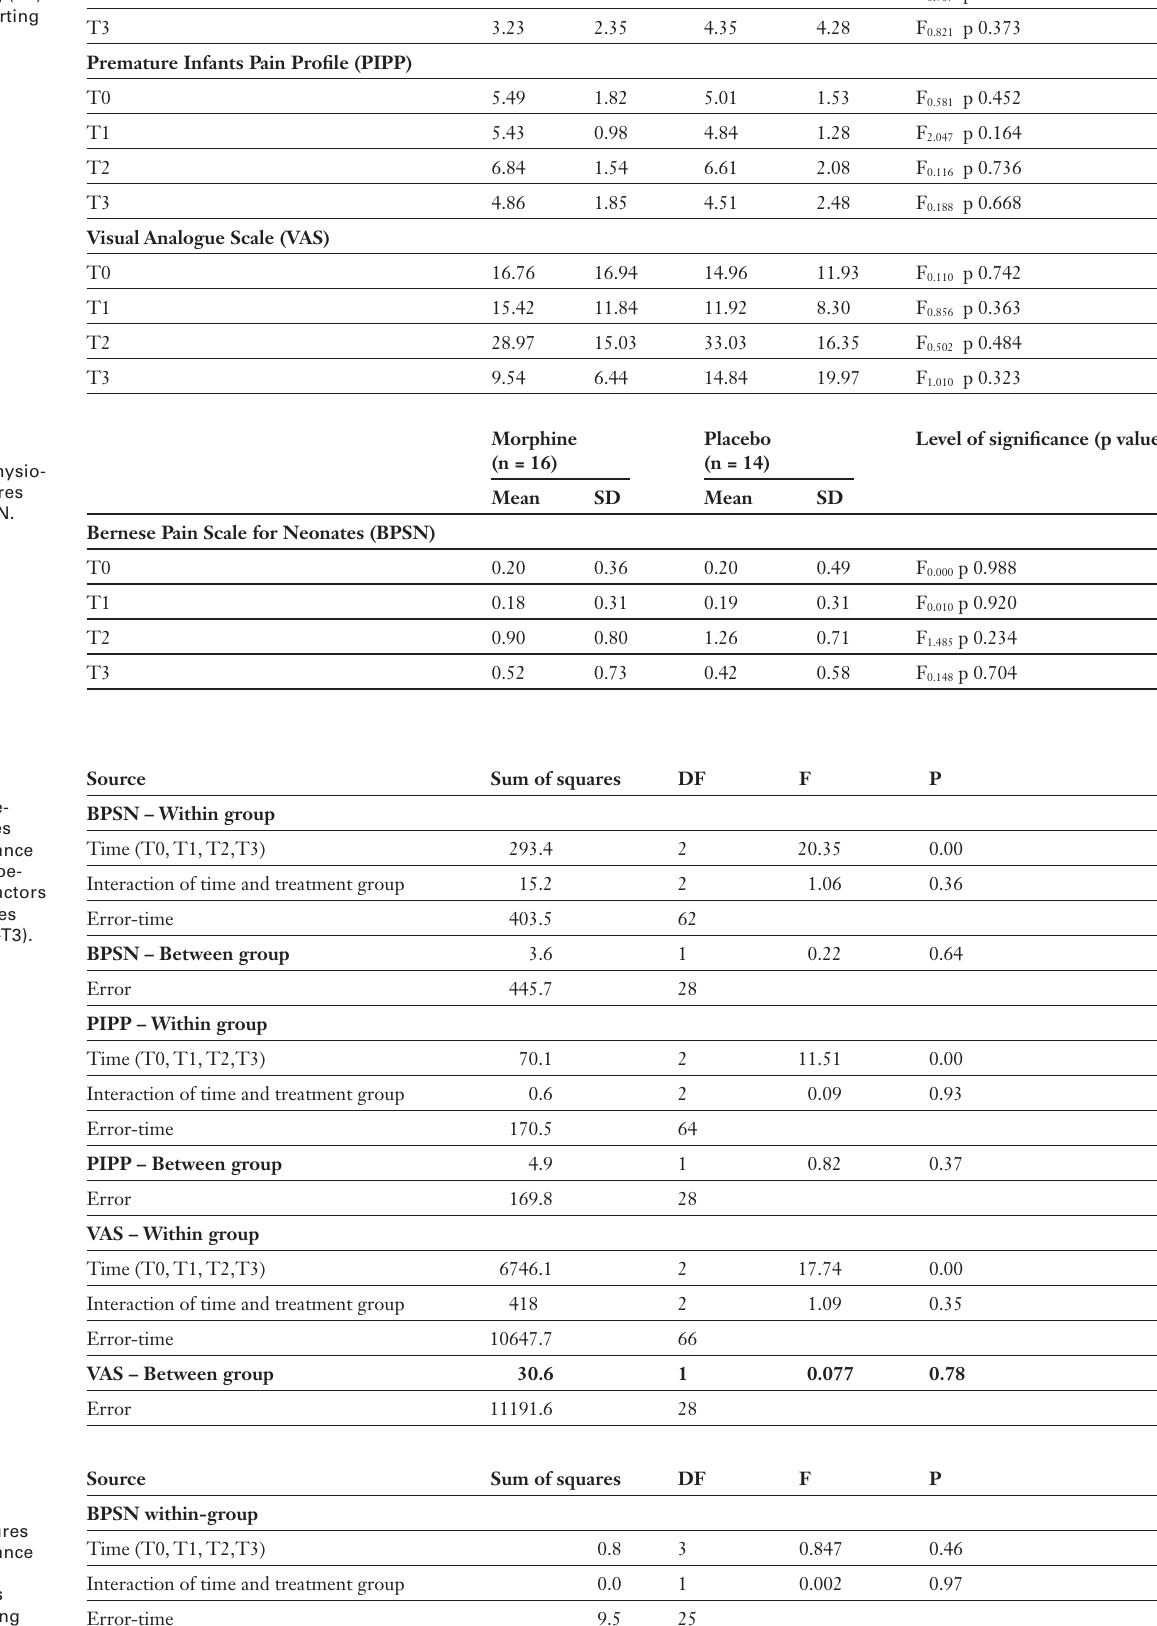
Results of the repeated-measures analysis of variance for within- and between-groups factors comparing BPSN physiological scores only during ETS